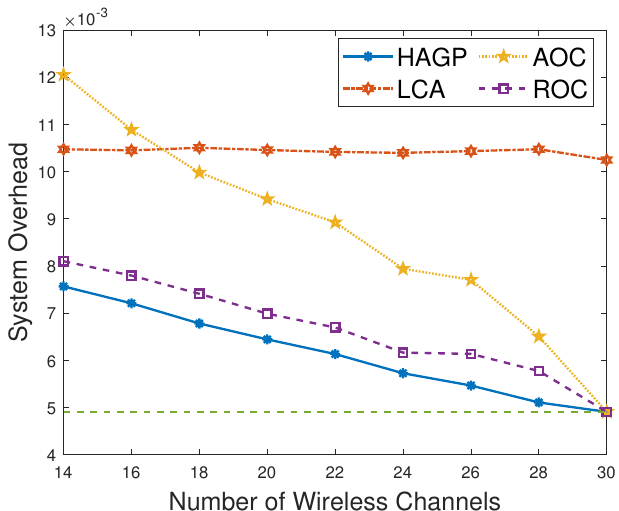
Figure 4. Overall system overhead vs. the number of wireless